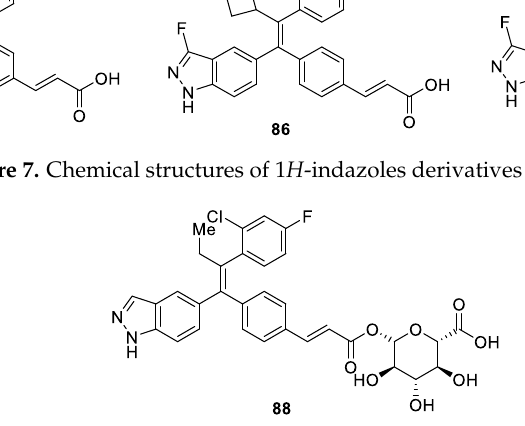
Figure 8. Chemical structure of 1 H -indazole derivative 88 .